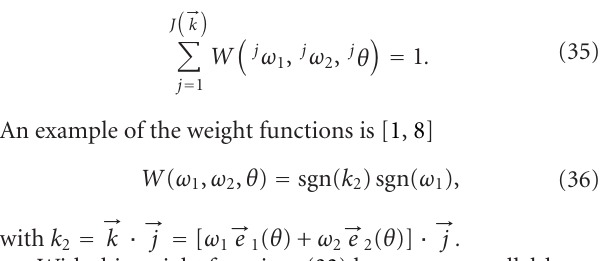
Figure 3: Nonuniqueness of the representation of a point in the Γ coordinates. (a) The Γ coordinate system, (b) a general curve Γ AB on the unit sphere, and (c) the intersections of Γ AB and the great circle orthogonal to a given vector may be scanned more than